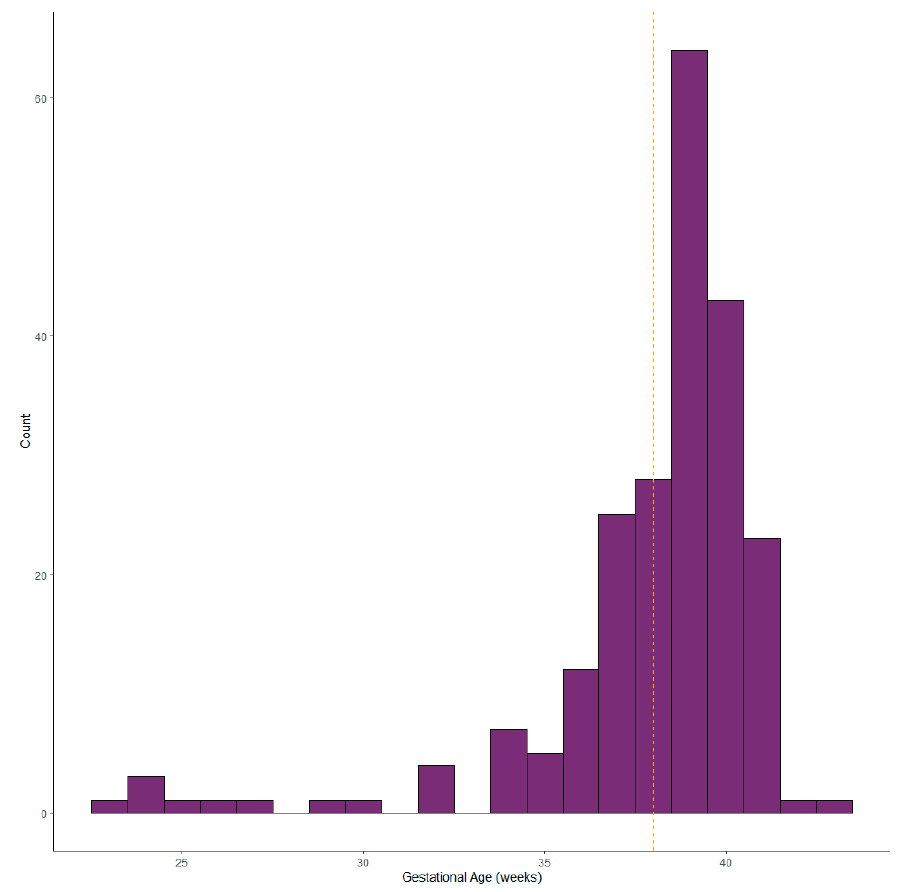
Figure 3. Congenital adrenal hyperplasia cases: distribution of gestational age ( N =